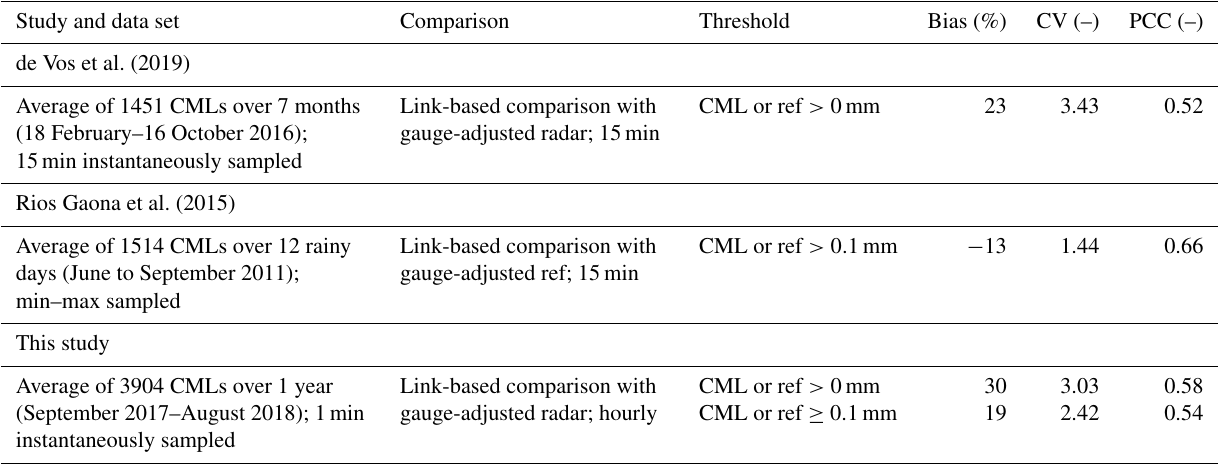
Table 3. Comparison of the performance measures to similar CML validation studies (only link-based comparisons) with respective thresh-